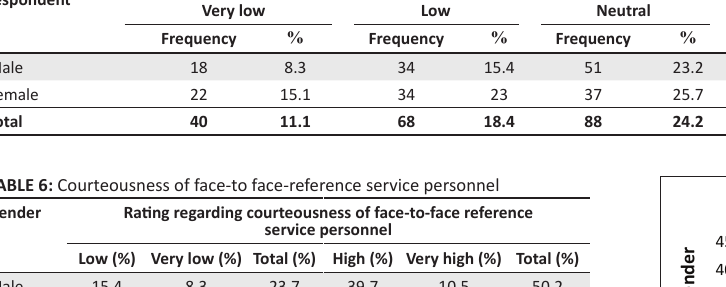
TABLE 5: Gender and willingness of face-to-face reference service personnel to help. Gender of